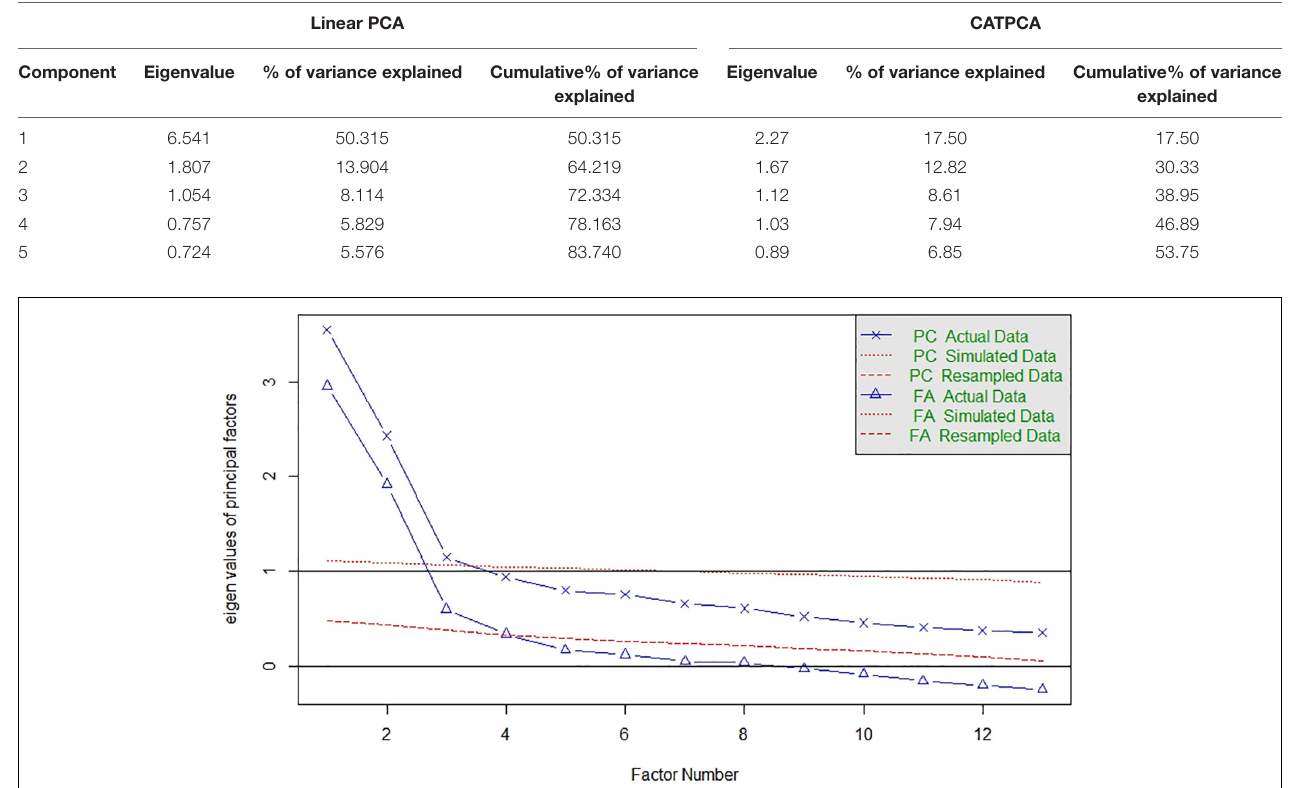
TABLE 3 | Results of PCA and CATPCA ( n = 2.407).